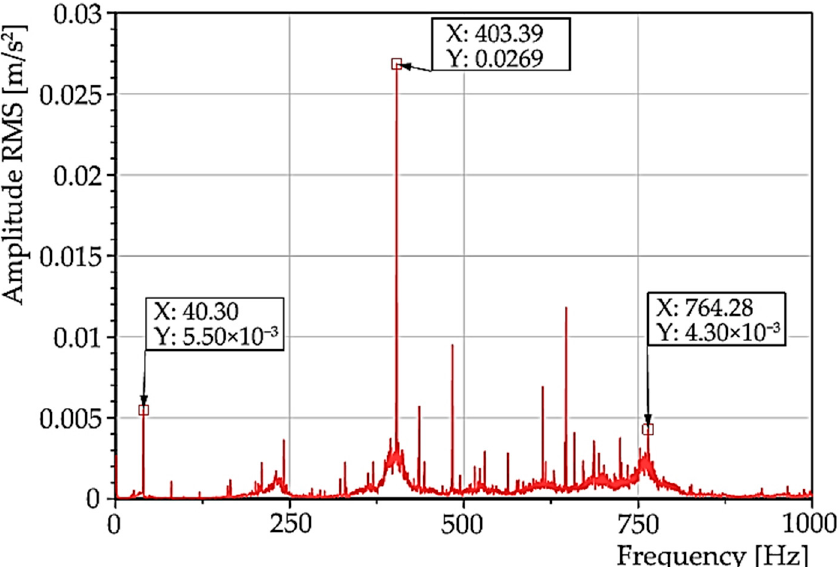
Figure 20. The spectrum of the effective acceleration value on a linear scale with significant amplitude at 400 Hz.